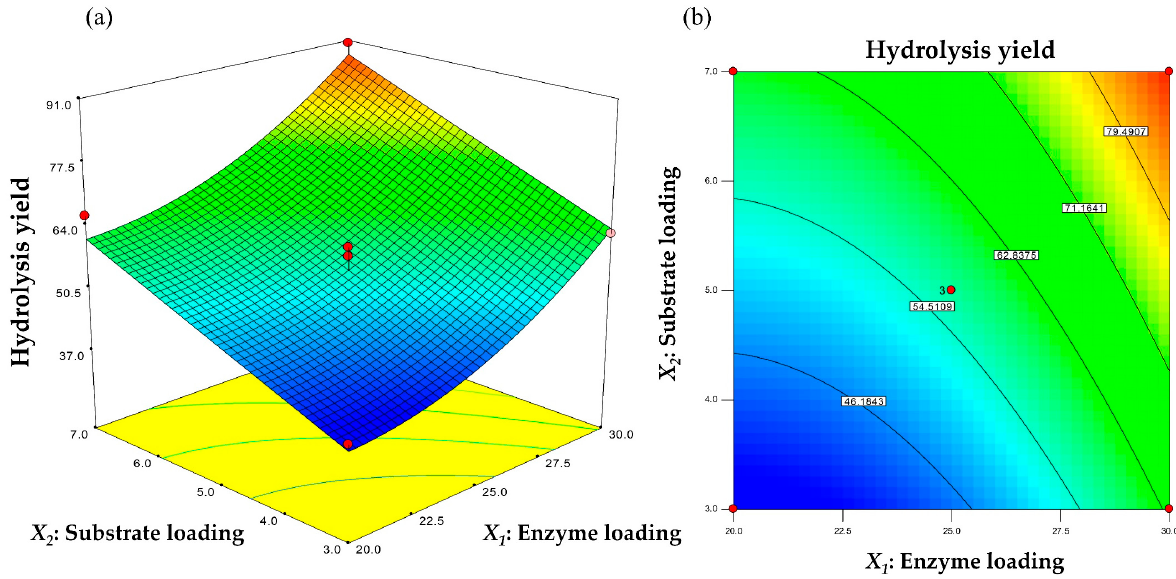
Figure 4. Response surface ( a ) and contour plots ( b ) of the combined effects between enzyme loading and substrate loading on hydrolysis yield.